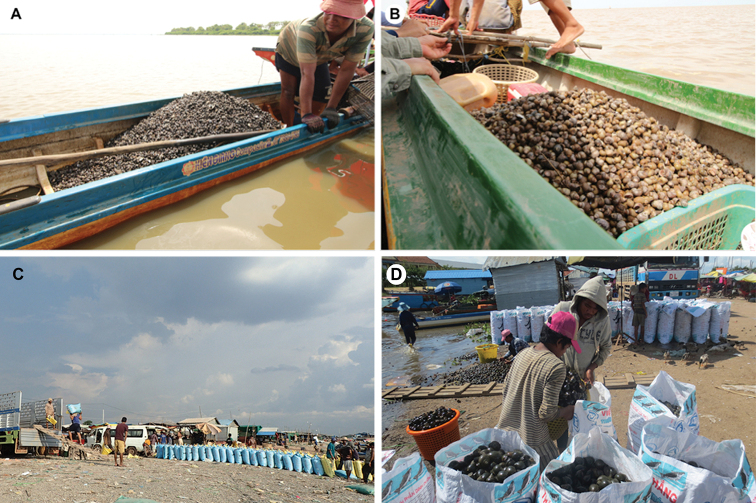
Freshwater mollusc fisheries at the Tonle Sap Lake, Cambodia. Small-scale harvesting of freshwater molluscs ACorbicula spp. and BMekongia
rattei, at open areas of the Lake. Freshwater molluscs CCorbicula spp. and DPila spp., being sorted and packed at main landing sites around the Lake. Photographs by A Pholyotha (A, B), TH Ng (C), PB Ngor (D).